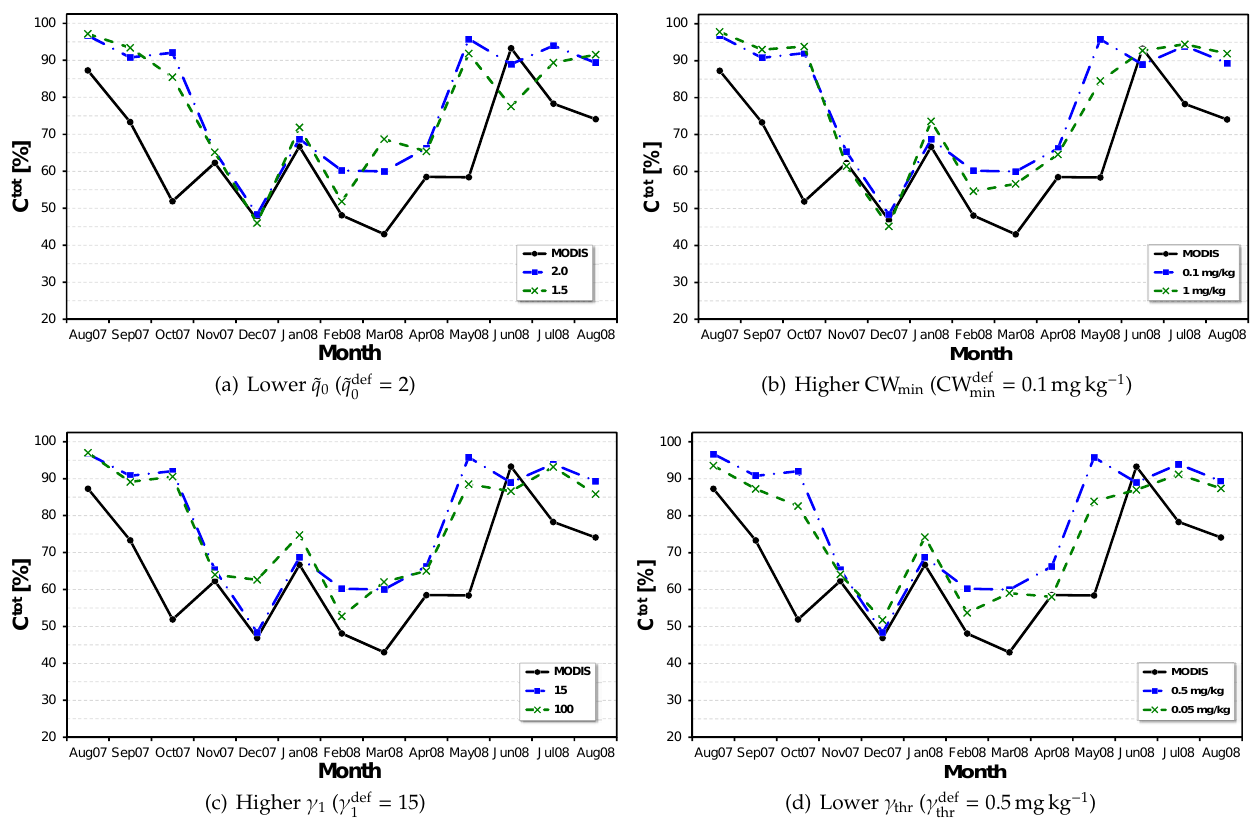
Figure 7. Monthly means of C tot (in %) from August 2007 to August 2008 referring to the NP-35 start position. The results originate from MODIS ( black line ) satellite observations, and HIRHAM5-SCM simulations using either the PS-Scheme and default model parameters ( blue line ) or the PS-Scheme with a single modified tuning parameter ( green lines